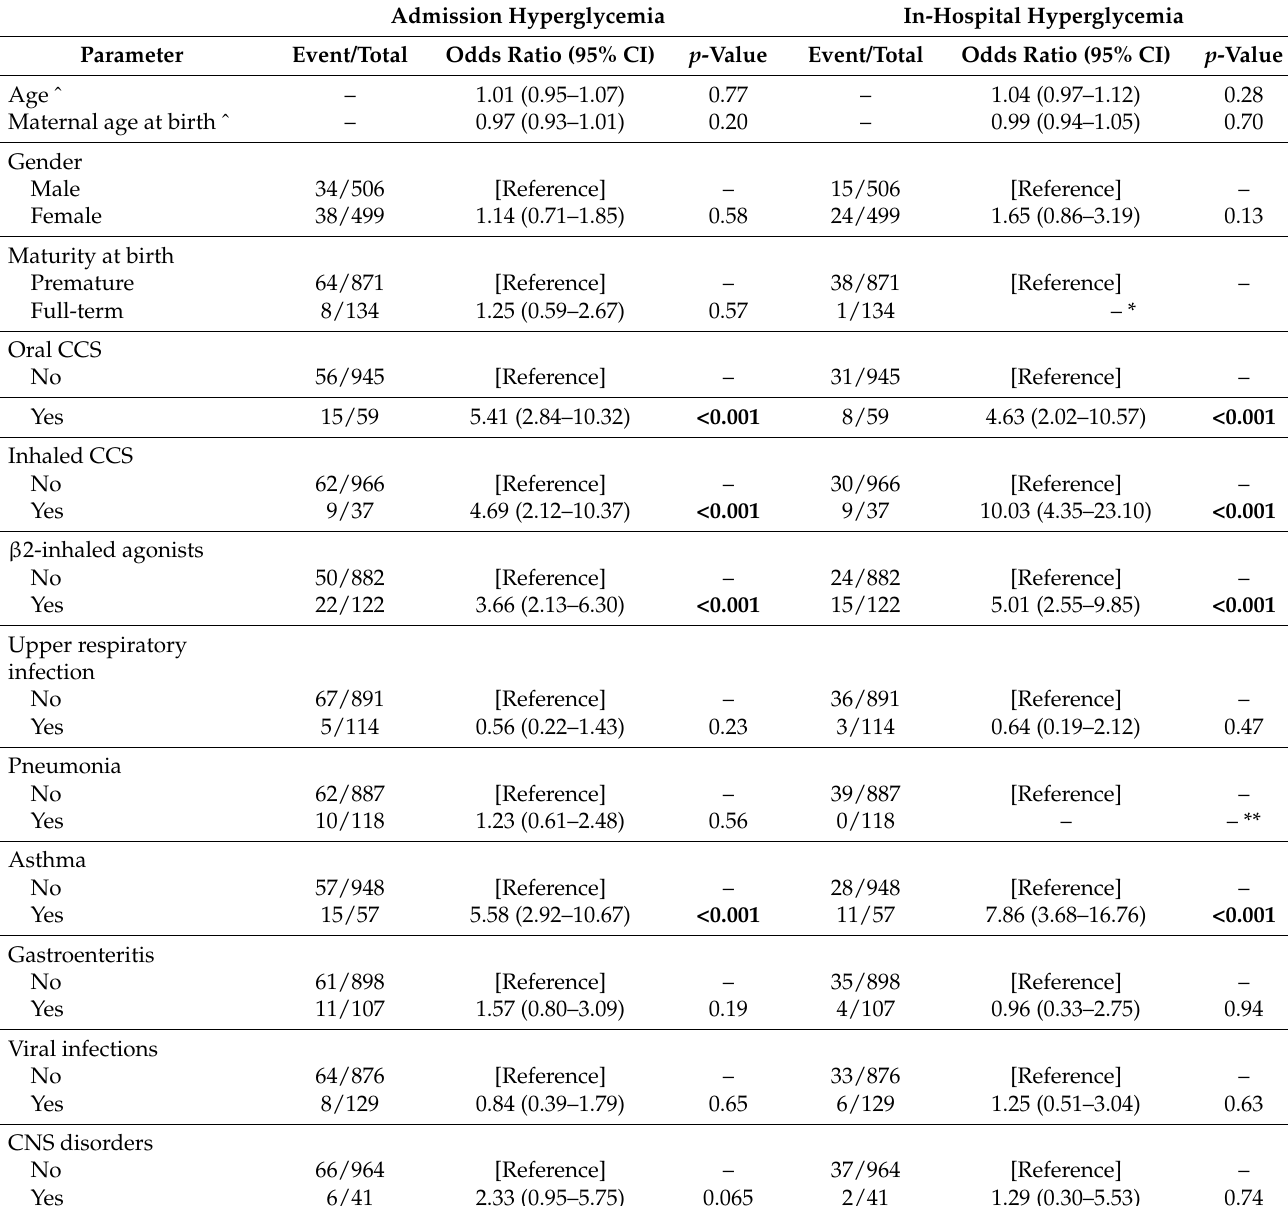
Table 4. Odds ratios estimated by univariate multivariate logistic regression models. CI: Confidence Interval; CCS: Corticosteroids. ˆ continuous variable. * Odds ratios were not calculated due to the extremely small number of the events of interest in the group of full-term children. ** Odds ratios were not calculated due to absence of the event of interest in the group of children with pneumonia. Significant p -values are shown in